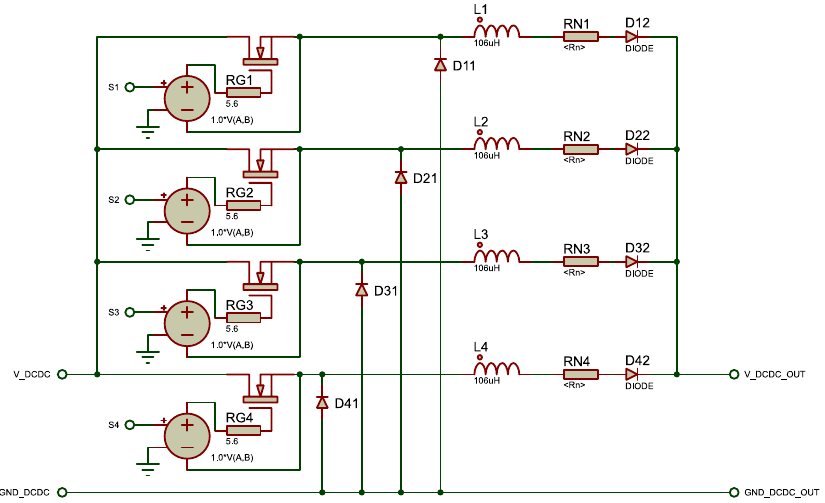
Figure 6. Simulation model of the four-leg buck converter with the parasitic resistance.